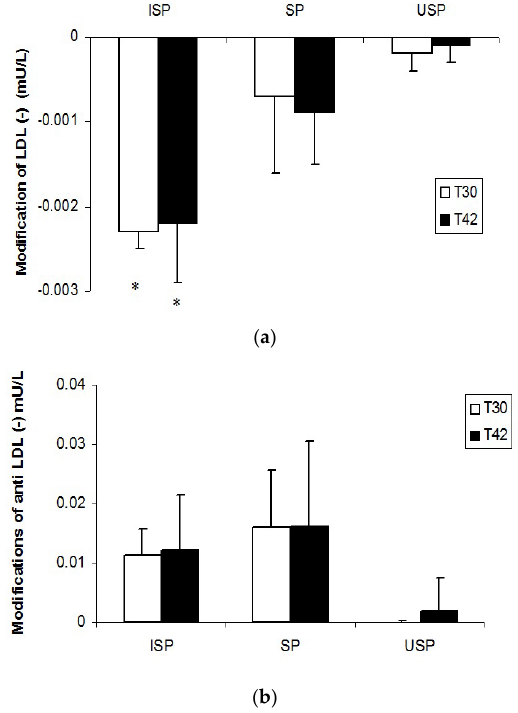
Figure 1. Electronegative low-density lipoproteins (LDL) (LDL ( ´ )) ( a ) and anti-LDL ( ´ ) autoantibodies ( b ) after 30 and 42 days of study (changes from baseline). * Different from the baseline ( p < 0.05). ISP Group: individuals who consumed the isoflavone-supplemented soy product; SP Group: individuals who consumed the soy product; USP Group: individuals who consumed the unfermented soy product (placebo). T0: baseline; T30: 30 days of daily consumption of soy products; T42: 42 days of daily consumption of soy